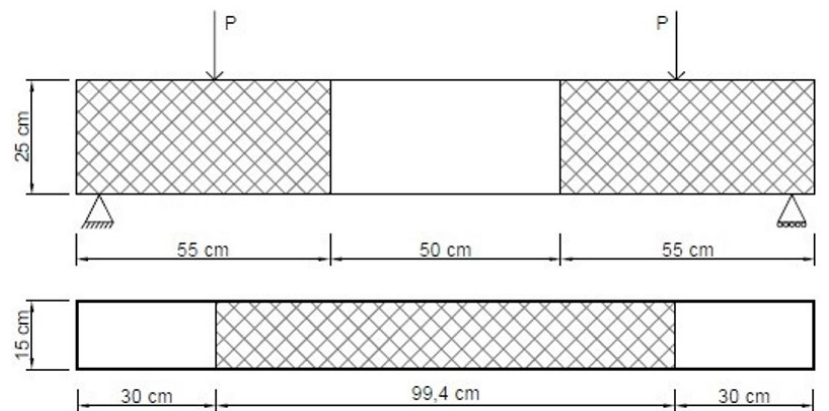
Figure 7. Regions of application of resin on the walls and bottom of the moulds,